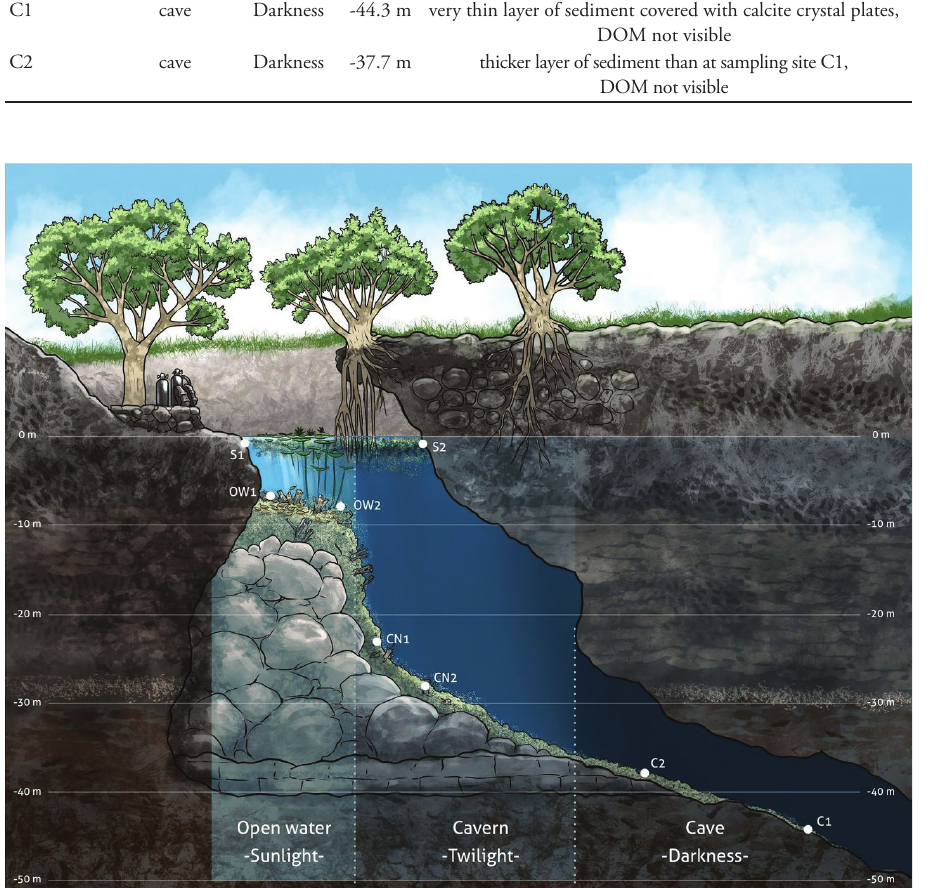
Figure 2. Schematic drawing of Cenote X-Batún with the four different zones of the cenote evaluated, and sampling sites in the sediment layer. S1 = water surface 1, S2 = water surface 2, OW1 = open water 1, OW2 = open water 2, CN1 = cavern 1, CN2 = cavern 2, C1 = cave 1, C2 = cave we counted the right valve only, when free valves were recovered. For each zone of the cenote, species average values were calculated. Individuals were deposited in Eppendorf tubes with 96% ethanol and are available in the collection of ostracodes of the Tec- nológico Nacional de México – I. T. Chetumal.